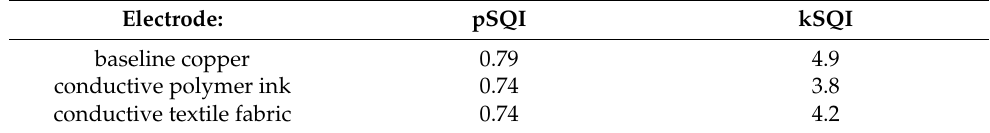
Table 3. Signal quality indices for each of the electrode cases.